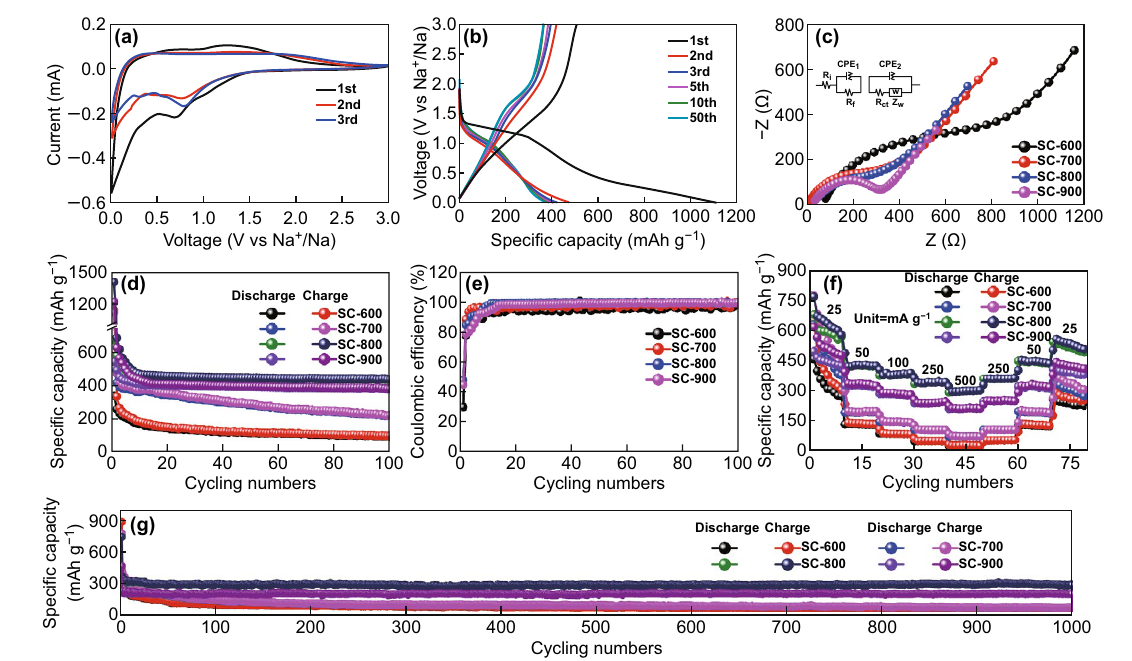
Fig. 3 a CV curves and b charge/discharge profiles of SC-800. c Electrochemical impedance spectra, d cycling performance, e Coulombic effi- ciencies, f rate performance, and g long-term cycling performance of SC-600, SC-700, SC-800, and